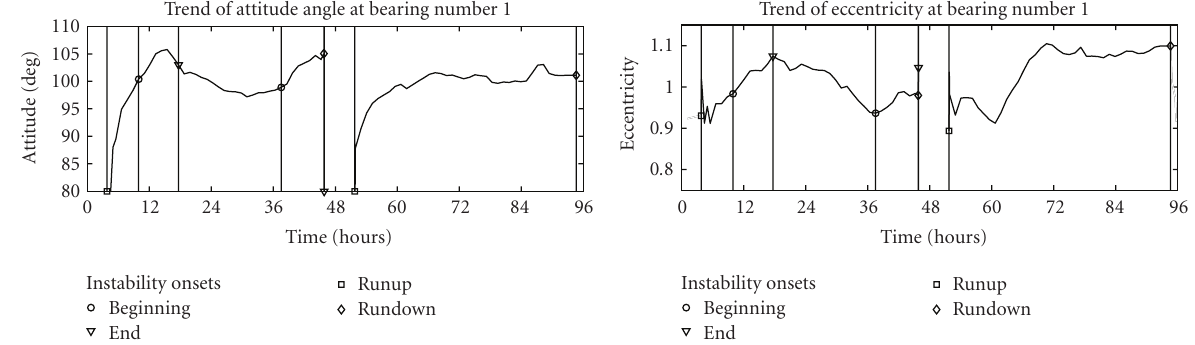
Figure 11: Dimensionless eccentricity and attitude angle of the journal of bearing no. 1 measured during a time interval within which two instability onsets occurred.